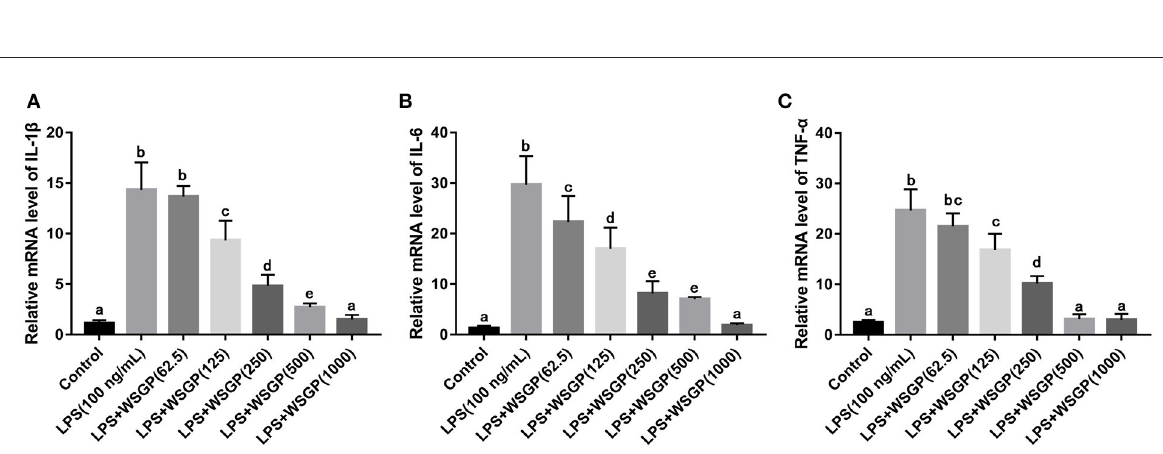
dose-dependently inhibited by 125–1,000 µ g/mL of WSGP ( p